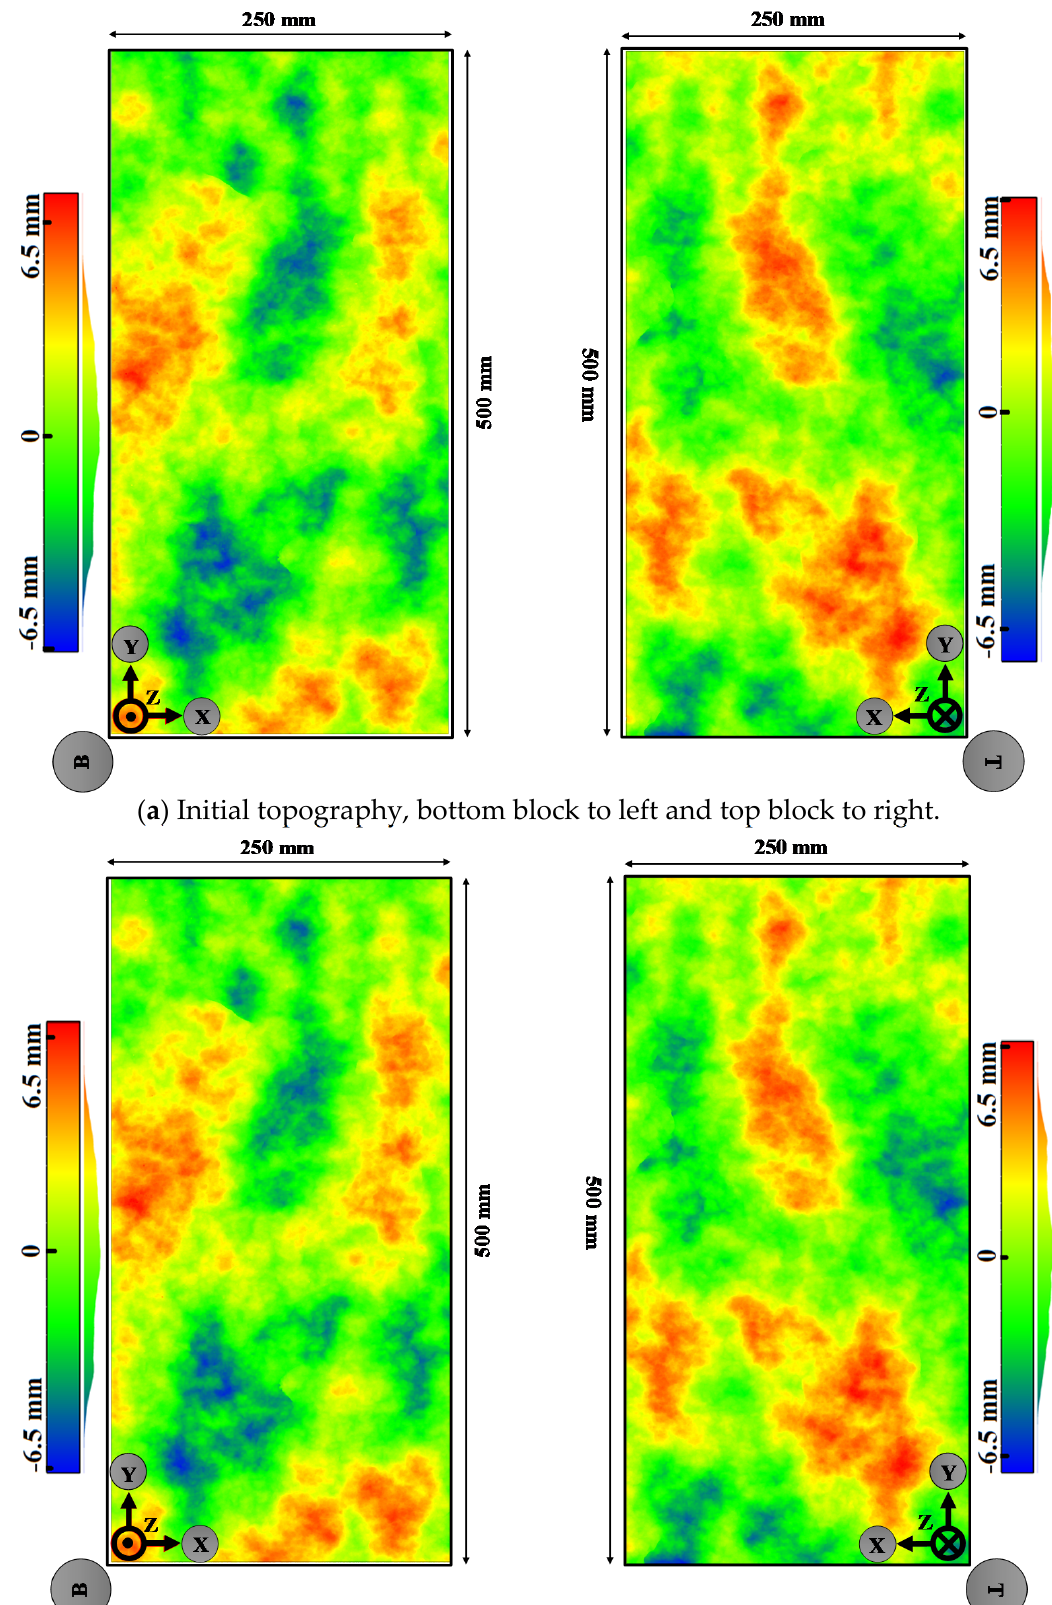
( b ) Sheared topography, bottom block to left and top block to right. Figure 8.